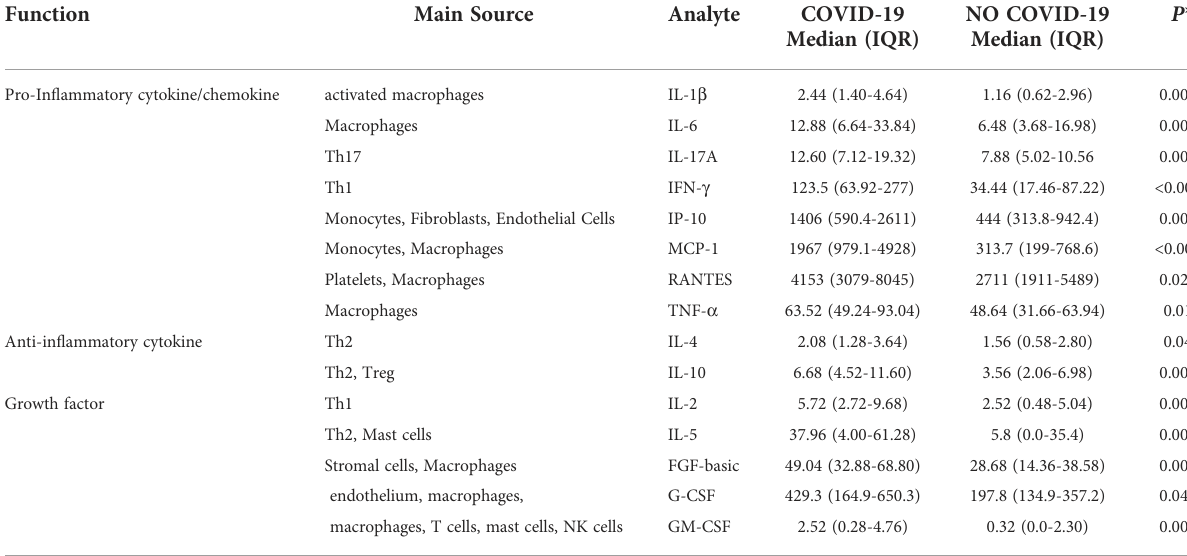
TABLE 3 The baseline plasma level of cytokines, chemokines, and growth factors found signi fi cantly elevated in COVID-19 patients compared to NO COVID-19 subjects of study population “ A ” .